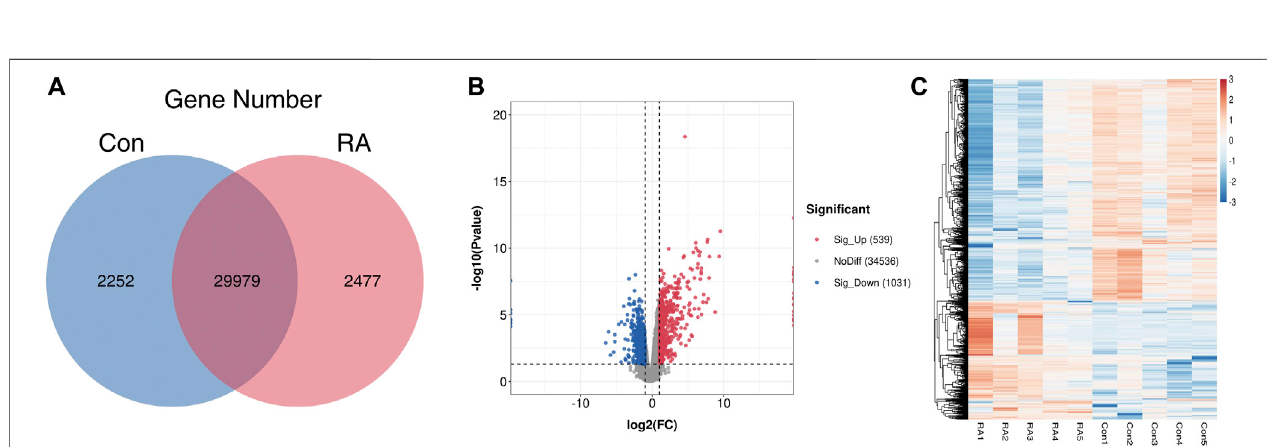
FIGURE 3 | RNA-seq data analysis and the differentially expressed genes between the RA and Con groups. (A) Venn diagram of RNA-seq data displaying the common and unique genes between the RA and Con groups. (B) Volcano plots showing the differentially expressed genes in RA PBMCs compared with those in the Con group. (C) Heatmap plots displaying the differentially expressed genes in RA PBMCs vs. those in the Con group. RA, rheumatoid arthritis; Con, control group; and PBMCs, peripheral blood mononuclear cells.